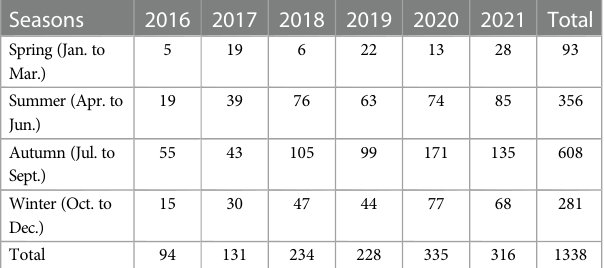
TABLE 1 Seasonal distribution of 1,338 Salmonella strains.